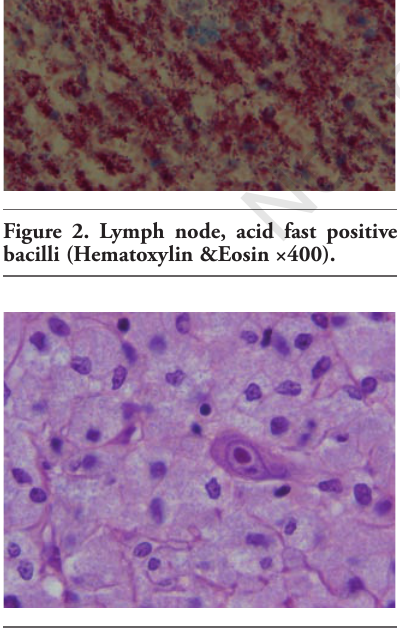
Figure 3. Lymph node, intranuclear cytomegalovirus inclusion body and plump histiocytes replacing the nodal architecture (Hematoxylin & Eosin